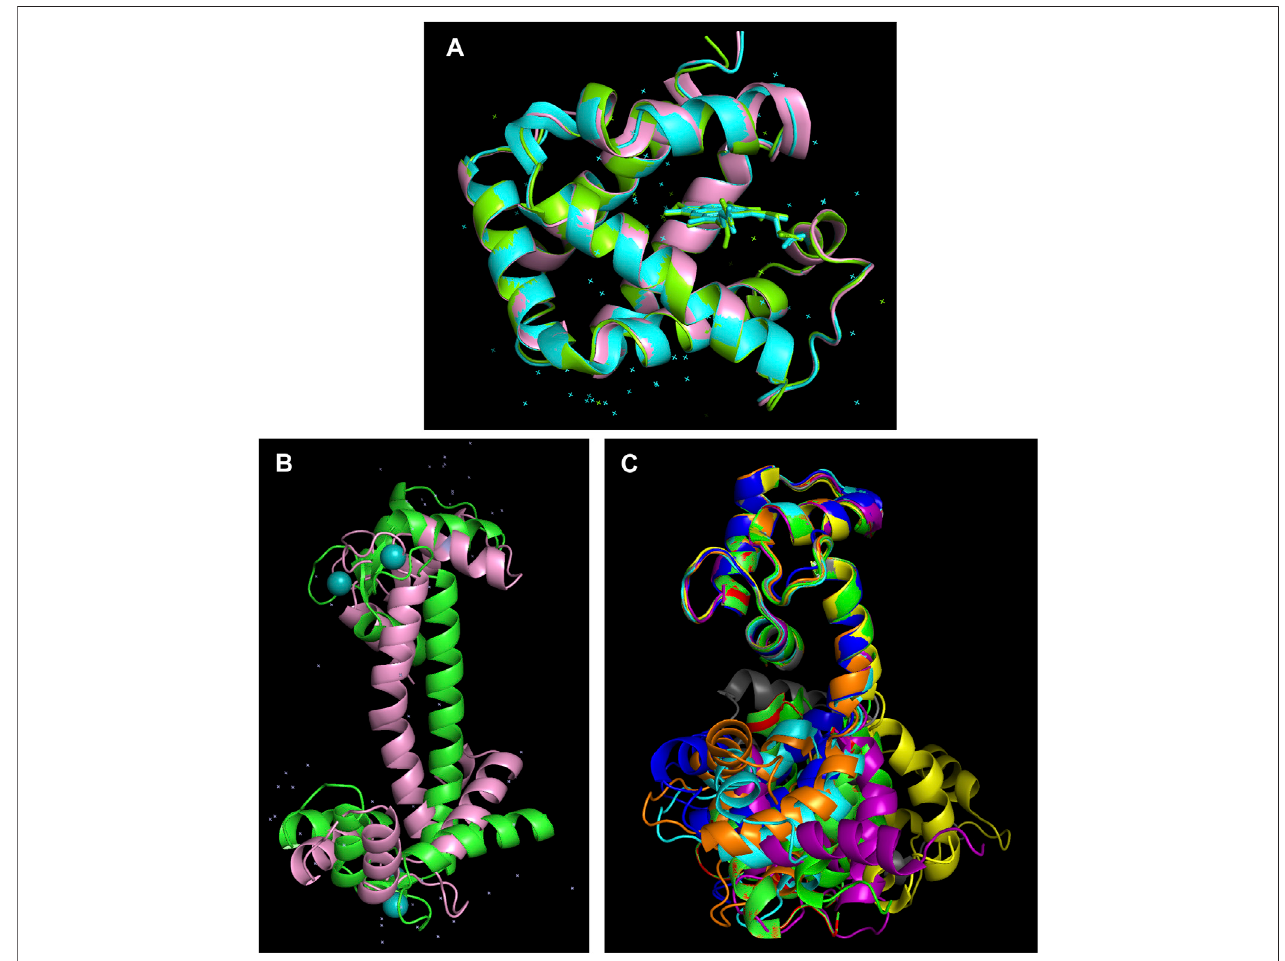
FIGURE5| AlphaFold2overlooksalternativeconformations. (A) Thehumanhemoglobin α -subunitinthetense(cyan,PDB1VWT)andrelaxed(green,PDB1RVW) forms solved by X-ray crystallography (Puius et al., 1998) superimposed on the AlphaFold 2 predicted structure (pink, https://alphafold.ebi.ac.uk/entry/P69905 ). Despite no heme group or water molecules being presentin the AlphaFold 2 input, the correct structure iscomputed with an RMSD of < 0.5 angstroms. (B) Calmodulin contains two well folded domains connected by a long, unstable α -helix. Bending in the central α -helix of the AlphaFold 2 model (https://alphafold.ebi.ac.uk/entry/ P0DP23) leads to large RMSD values relative to the X-ray crystallography structure of the Ca ++ -bound form of calmodulin (PDB 3CLN) (Babu et al., 1988). (C) NMR solution structures reveal that the central α -helix is disordered in the absence of Ca ++ provoking signi fi cant conformational diversity which is highly relevant for the protein ’ s biological function (Zhang et al., 1995) (Kainosho et al.,